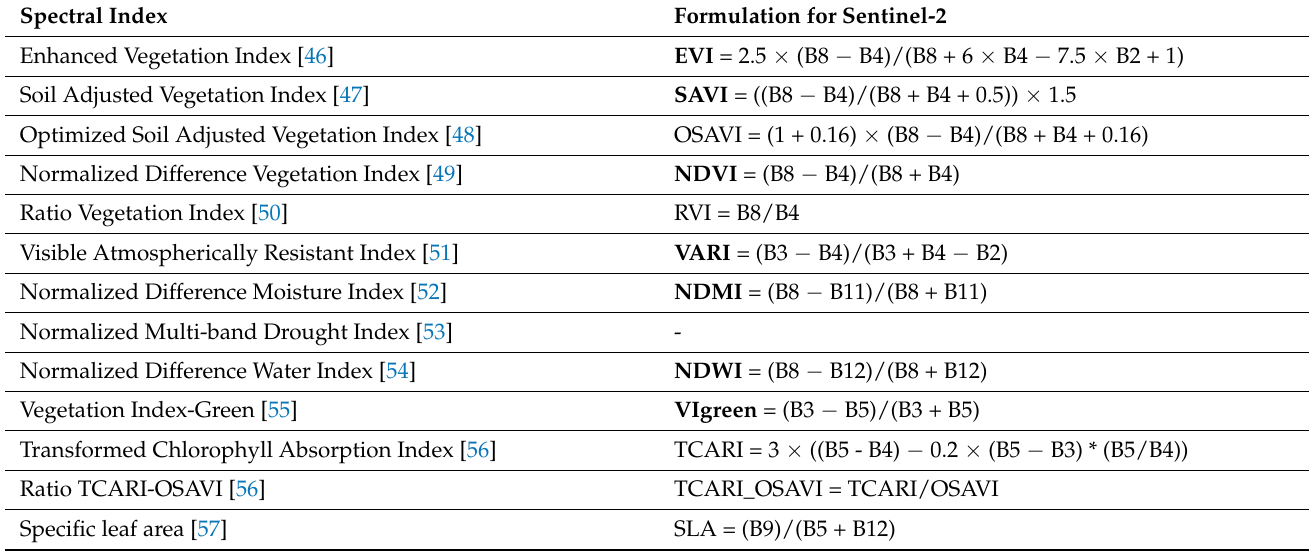
Table 3. Spectral indices obtained from Sentinel-2 images and formulas with the band numbers. Formulation for